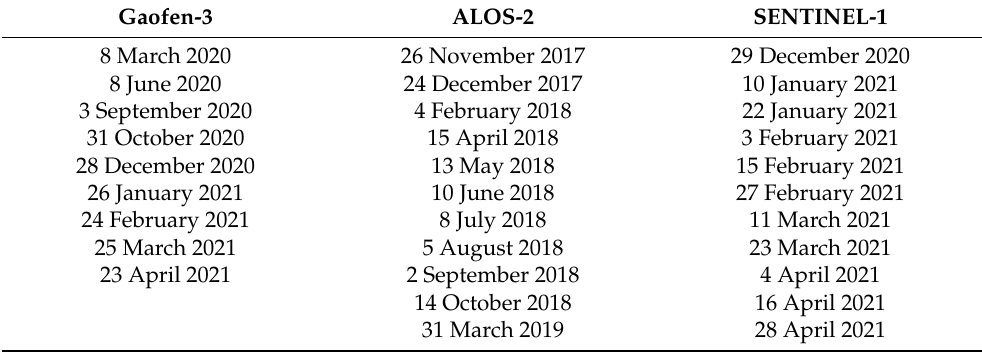
Table 1. SAR acquisition dates.